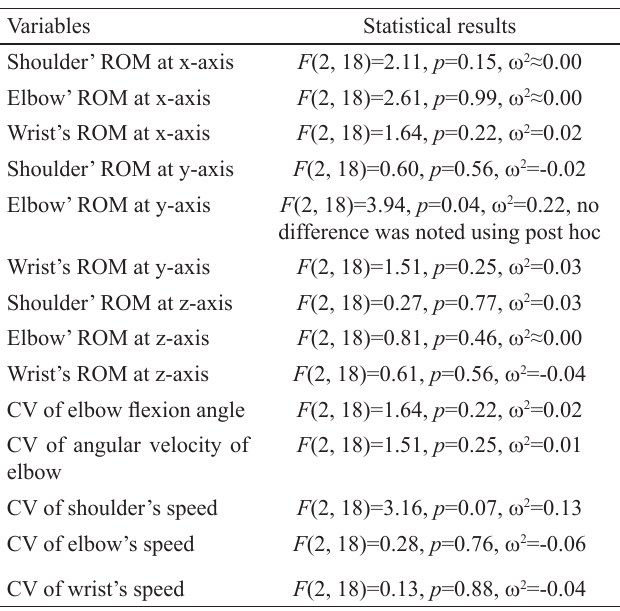
6. Statistical results of the comparison of the average of shoulder, elbow and wrist’s linear ROM of each direction between the cycles and the comparisons of the coefficient of variation (CV) of the elbow flexion angle, angular velocity of elbow, and linear speeds of shoulder, elbow and wrist between the